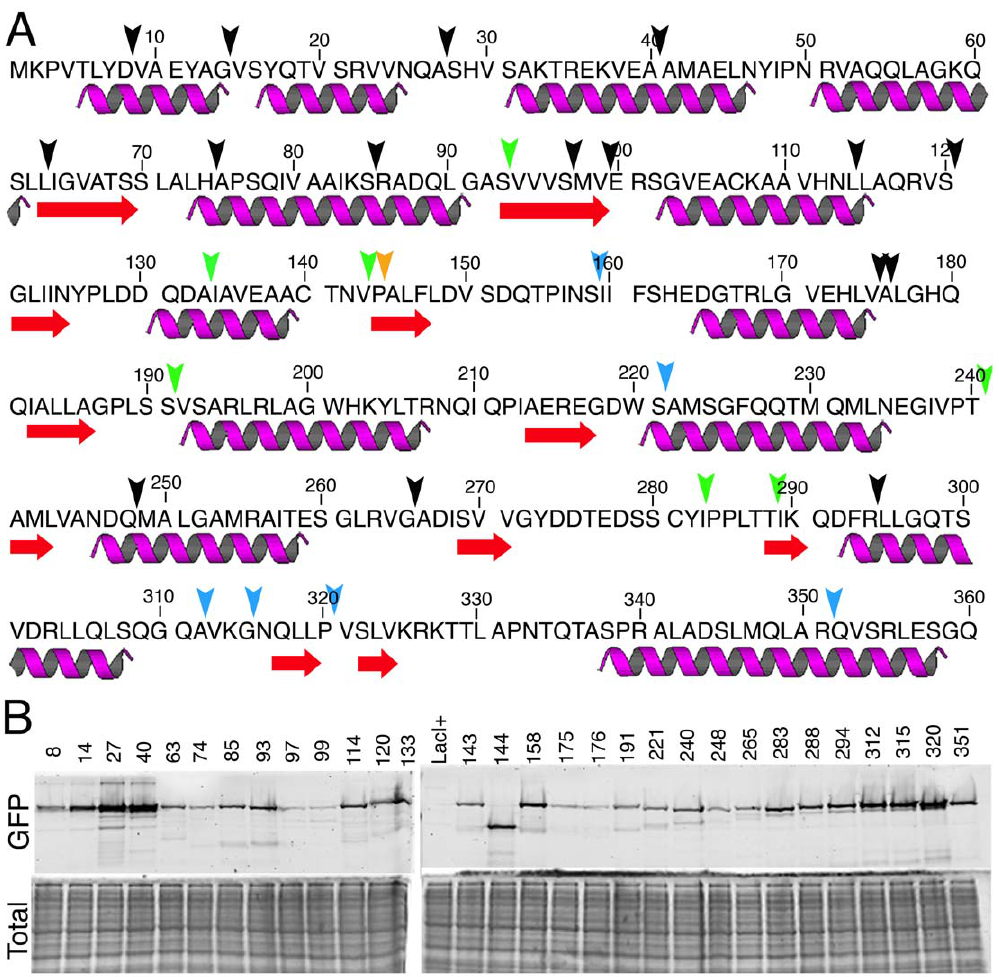
Figure 2. Analysis of TAGIT-2-constructed GFP insertions in the E.coli lactose repressor LacI. (A) Amino acid sequence and structural features of LacI, with purple helices indicating a 2 helices and red arrows indicating b -sheets. Black arrowheads indicate the position of non-functional GFP insertions (Repression 2 , Focus 2 ). Green arrowheads indicate GFP insertions that fail to repress lacZ , but form foci (Repression 2 , Focus + ) when introduced into a strain with the lacO array integrated near the terminus of replication. Blue arrowheads indicate insertions that repress lacZ (Repression + , Focus + ). The orange arrowhead indicates the position of the GFP insertion that is out of frame on the 3 9 side of GFP. (B) The LacI-GFP insertions accumulate to variable levels. Numbers correspond to the last undisrupted lacI codon before TAGIT. Cells were harvested at an OD 600 of , 0.5, samples prepared and subject to SDS-PAGE. Protein accumulation was determined using in-gel GFP fluorescence (top panel) and the gel was subsequently stained with Coomassie blue to reveal total protein (bottom panel).